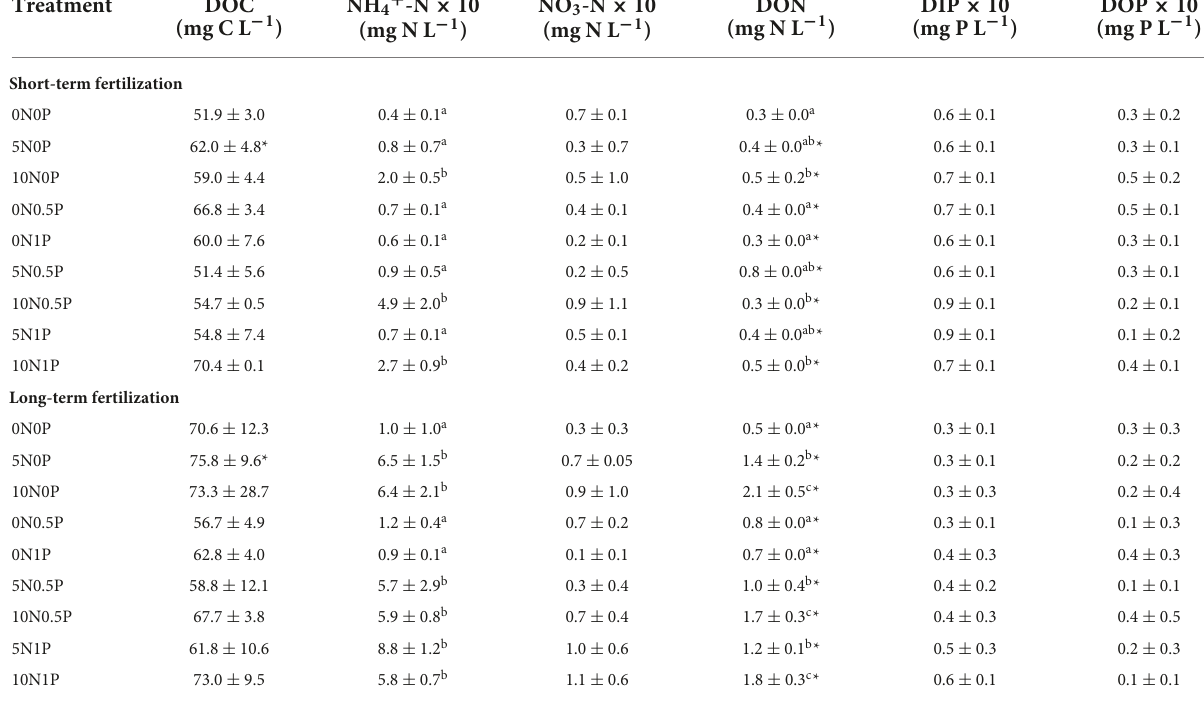
TABLE 2 Porewater chemical properties under different treatments in the short- and long-term fertilizations.